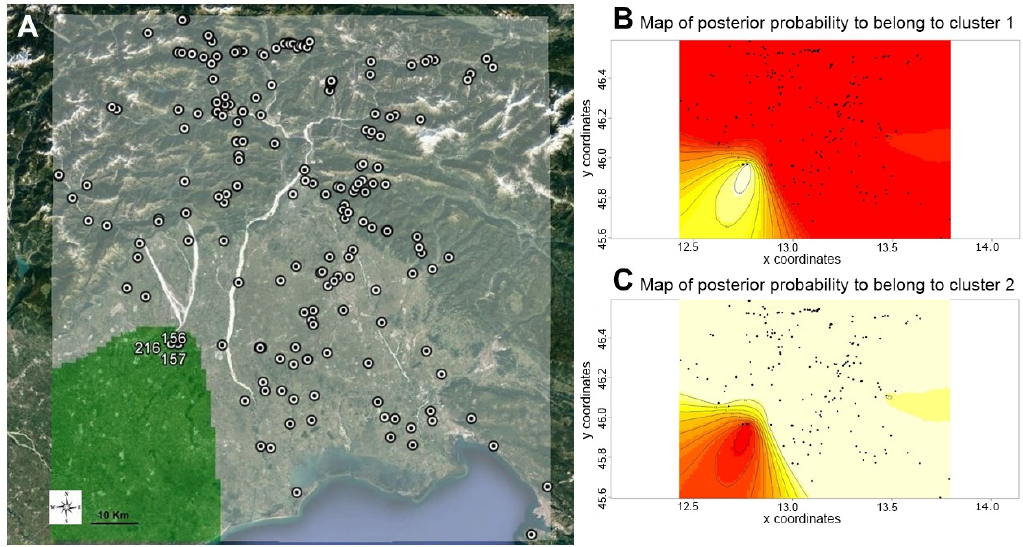
Figure 5. Results of Geneland analysis of 215 walnut ( Juglans regia L.) accessions for K = 2. ( A ) Map of estimated population membership plotted on Google maps, with cluster 1 in green and cluster 2 in white. The accession IDs of the three individuals in cluster 1 are recorded (see text for details). ( B ) and ( C ) are maps of posterior probabilities of cluster 1 and cluster 2, respectively. Contour lines represent posterior probabilities of belonging to cluster 1 (B) and 2 (C). Table 5 . Genetic diversity within the five populations of Persian walnut (between brackets the no. of samples) collected in the Friuli Venezia Giulia Region assessed with 20 SSR loci. A = no. of alleles, Ne = effective no. of alleles, Rs = allelic richness, Ho = observed heterozygosity, GD = gene diversity, Pa = private alleles (the private allele length is listed in brackets).